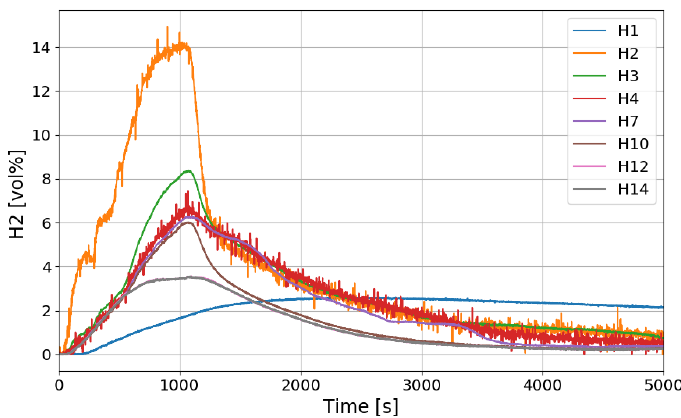
Figure 16. Hydrogen concentration distributions along a center line for the SP3 test.